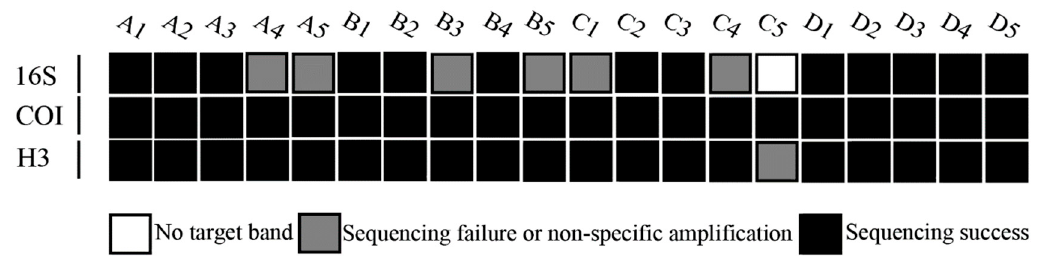
Figure 1. Polymerase chain reaction ( PCR) amplification of three genes: ( a ) 16S , ( b ) COI , and ( c ) H3 . The code in the agarose gel image corresponds to the code in Table 1.